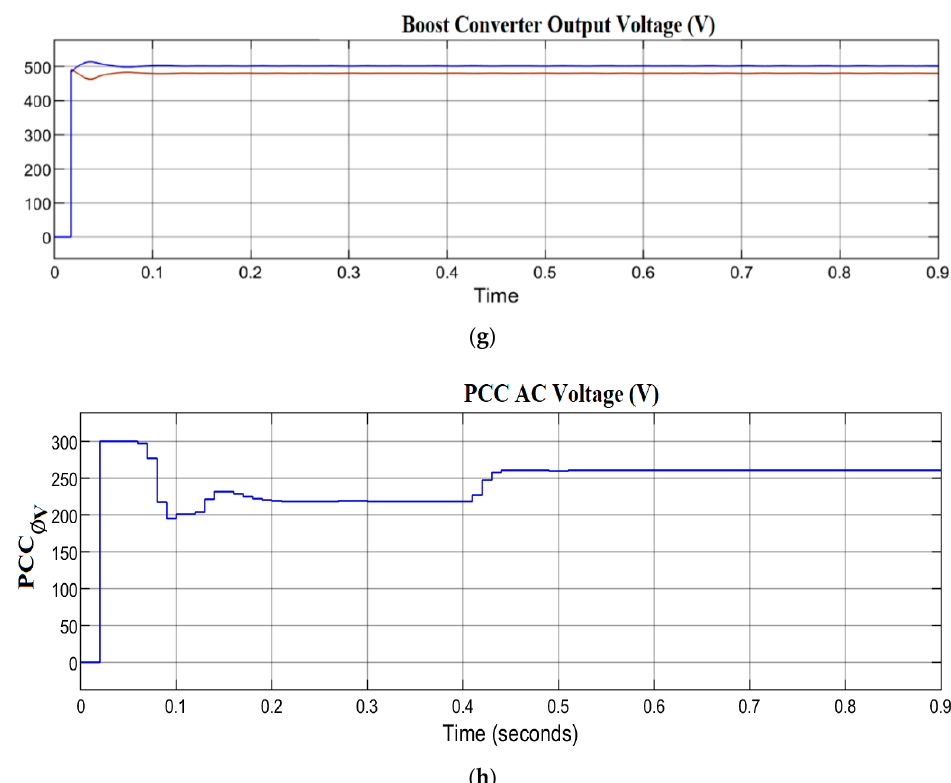
Figure 13. ( a ) UPF Mode Operation, ( b ) PV Output Power, ( c ) Boost Converter Duty cycle, ( d ) PPPT Tracking, the blue is the tracking sequence while the green line is the error regulator ( e ) Boost Converter Duty Cycle, ( f ) PV Output Voltage, ( g ) Boosted Voltage, ( h ) PWM-VSC Converting 500 V to 260 VAC.